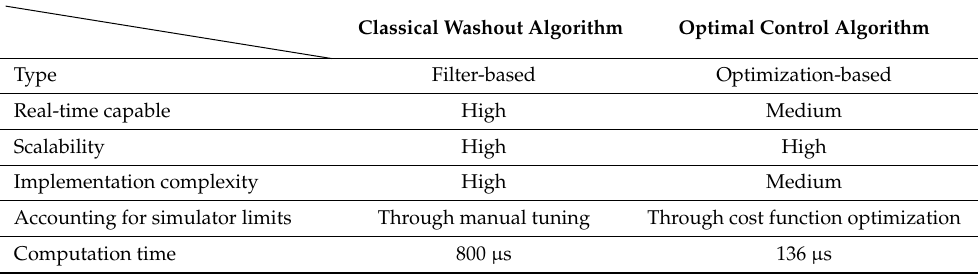
Table 3. The qualitative comparison of different algorithms.